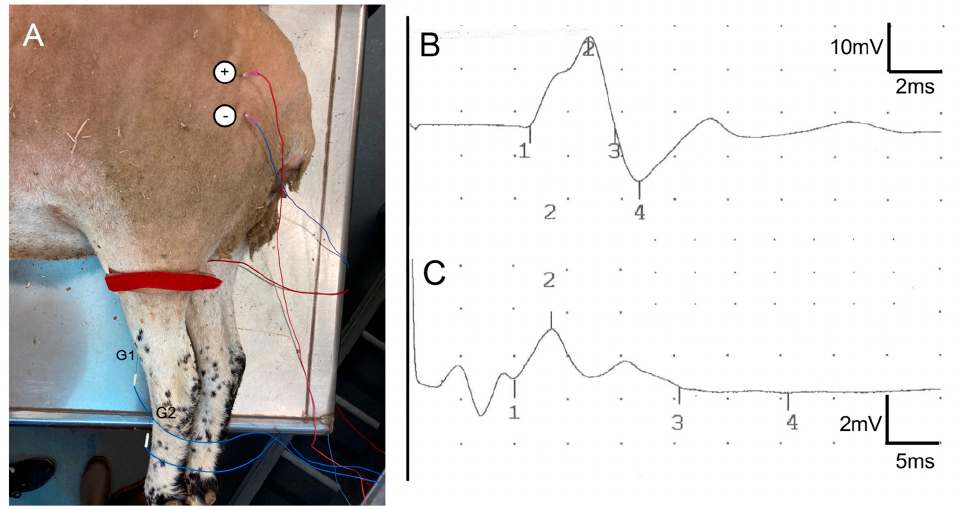
Figure 10. ( A ) Setup used for the nerve conduction studies. Stimulating needle electrodes were placed at the sciatic notch to stimulate the nerve (+– − ), whereas recording needle electrodes were placed at the TA muscle (active electrode, G1) and at the distal tendon (reference, G2). The red band corresponds to the ground electrode. ( B , C ) Sample EMG recordings at 9 mpo. Top trace ( B ) shows the CMAP in the control hindlimb, and the bottom trace ( C ) in the operated hindlimb of a sheep of AG7 group. The onset of the CMAP is labeled with mark 1, the negative peak of the CMAP with mark 2, and the end with mark 3. Note the differences in time and voltage scales, noted at the right of each trace.